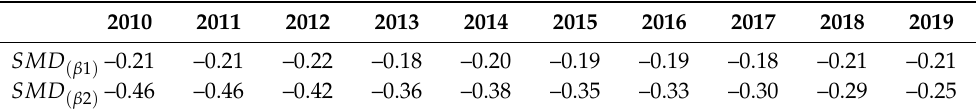
Table 5. Assessment of the impact of urban sprawl on local and national economic growth using the standardized mean difference (SMD)